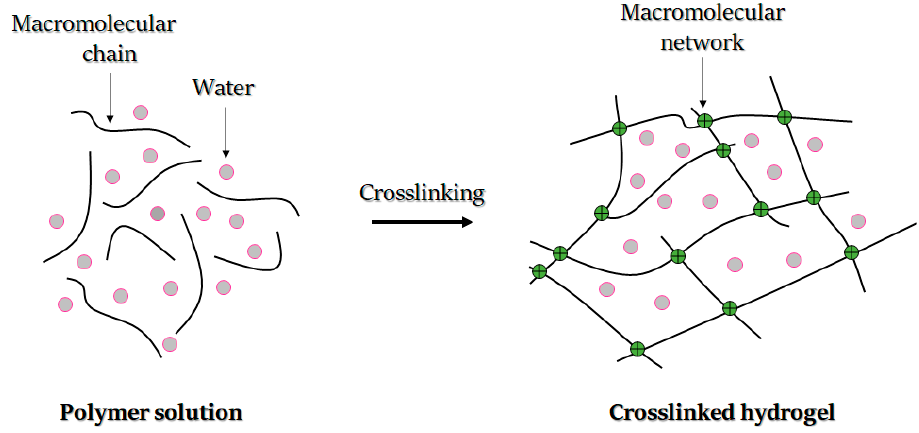
Figure 7. Principle of the hydrogel formation.